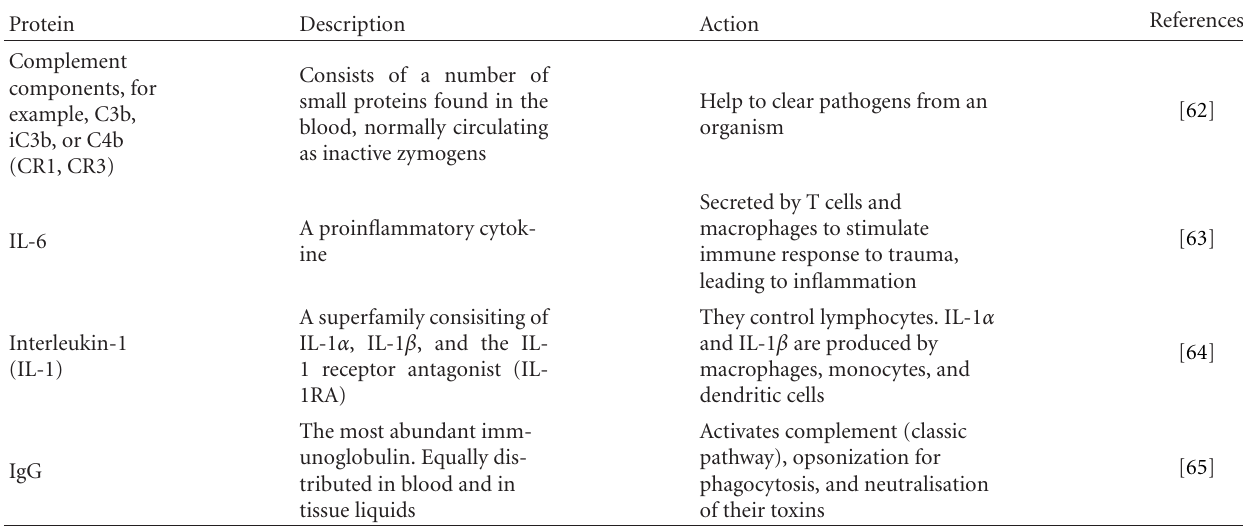
Table 2: The host immune response will most likely make up the majority of proteins present in the CSF because these proteins will include host immune response factors such as complement and cytokines as well as specific immunoglobulins and proteins from serum leaking to the CSF as a result of the blood brain barrier breakdown.